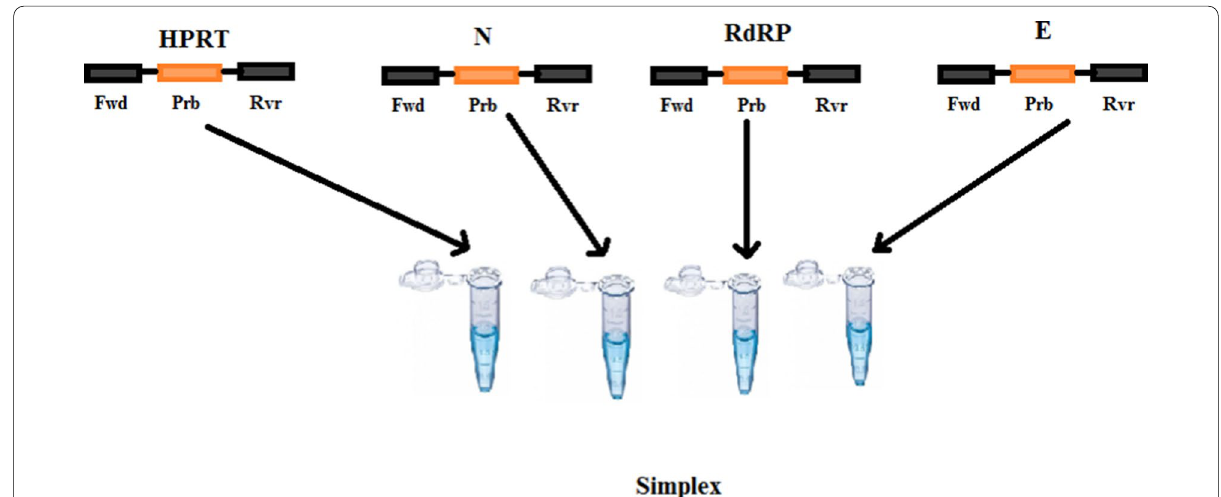
Fig. 1 Experimental design of